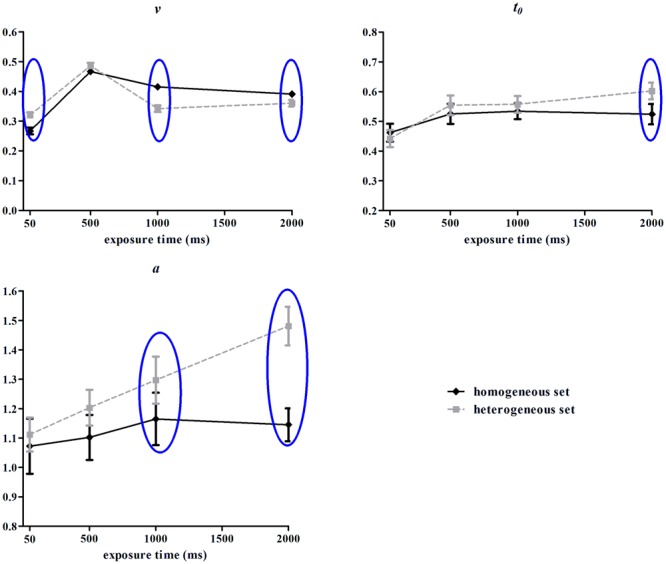
Drift rate (v), boundary separation (a), and non-decisional time (t0) from hierarchical diffusion model (HDM) analysis in Experiment 2. Error bars represent one standard error of the means. Blue circles indicate statistical significance (p < 0.05).